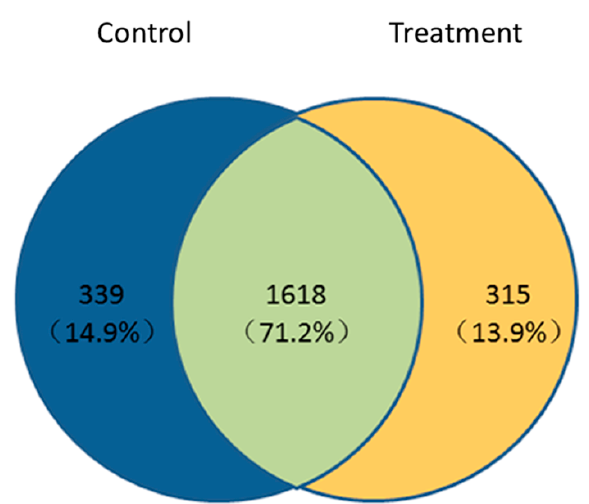
Figure 5. The changed in the proteome distribution between the control (CK + TMV) and treatment ( A13 + TMV) groups, the diagram shows both unique and shared proteins. Blue indicates DEPs were identified in the control, orange indicates DEPs were identified in the treatment, and green indicates DEPs were identified in both treatment groups.